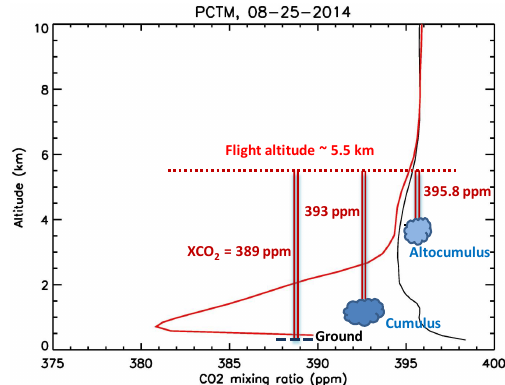
Figure 12. Vertical profiles of CO 2 mixing ratio on 25 August 2014 for the central location of segment A at 41.1 ◦ N, 92.3 ◦ W in black and of segment B at 41.3 ◦ N, 94.7 ◦ W in red from the NASA Param- eterized Chemical Transport Model. The XCO 2 measurements to ground, PBL cumulus clouds and mid-altitude altocumulus clouds from the CO 2 Sounder lidar for segment B are labeled. Flight alti- tudes were around 5.5km above sea level for both segments, shown as a red dashed